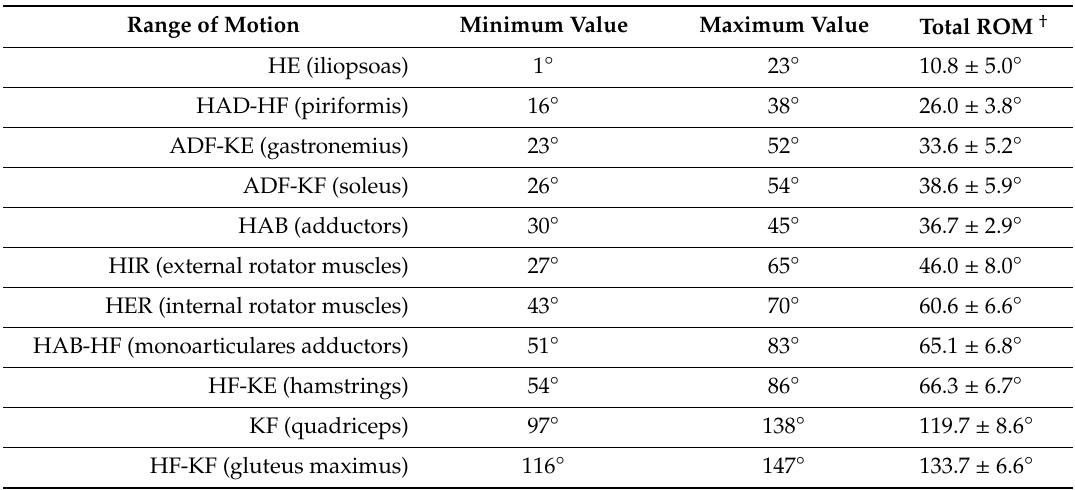
Table 2. Lower-extremity flexibility profile in 74 youth competitive inline hockey